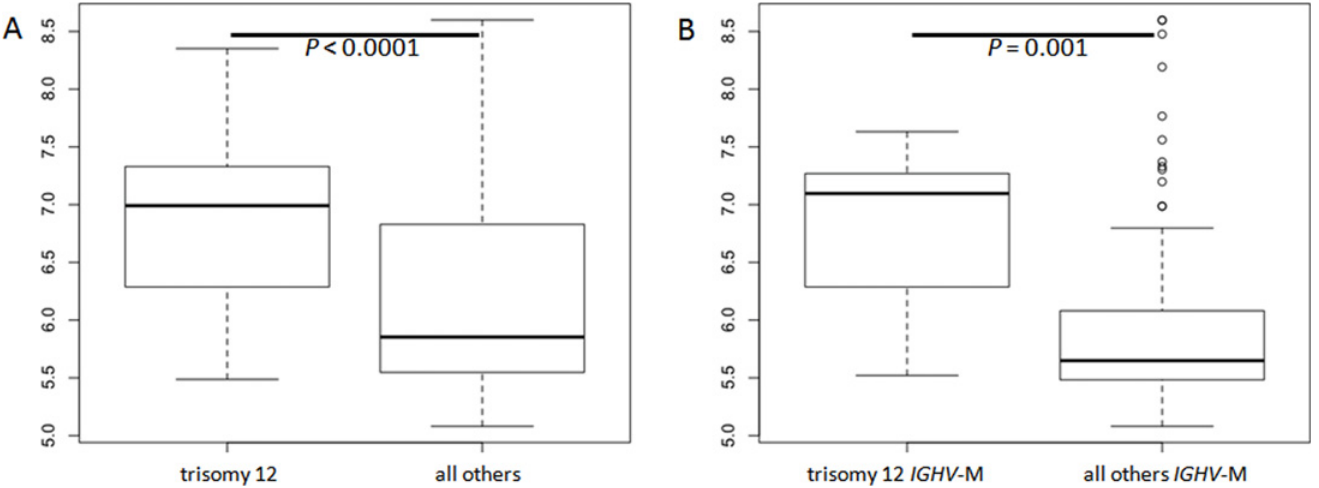
Fig 2. Boxplot of IGF1R expression in: A) Trisomy 12 vs no trisomy 12 patients; and B) Trisomy 12 vs no trisomy 12 considering only IGHV -M patients.